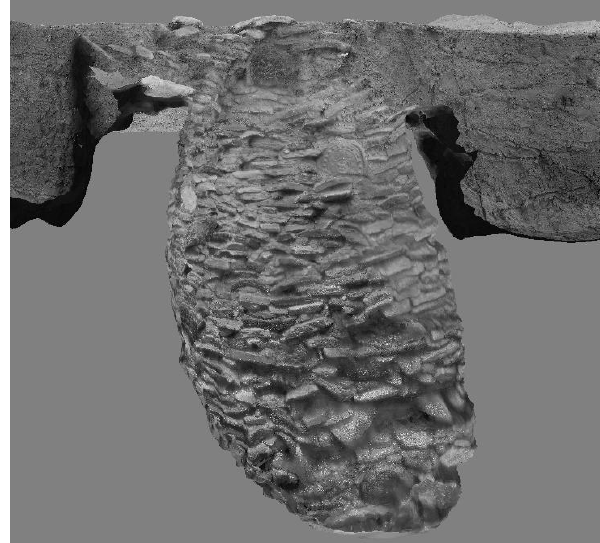
Figure 2. 3D model of the water well in Saidaiji Temple.